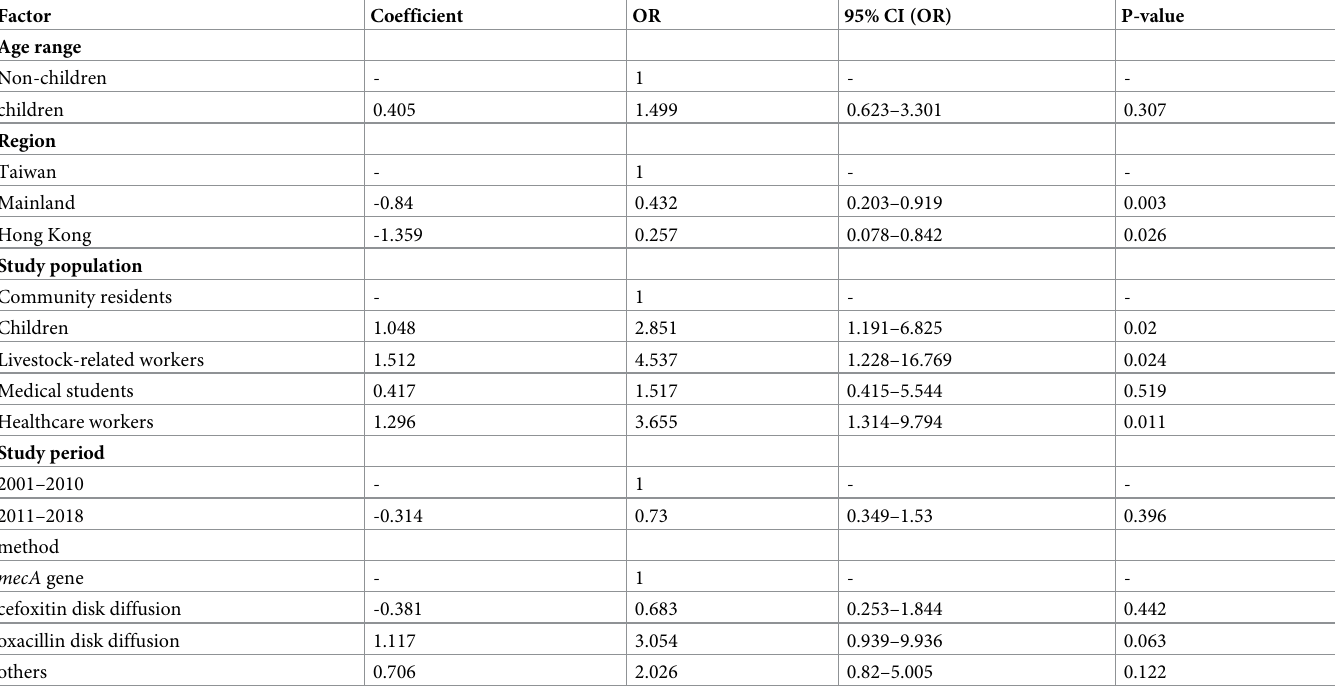
Table 3. Summary results of meta-regression for the prevalence of